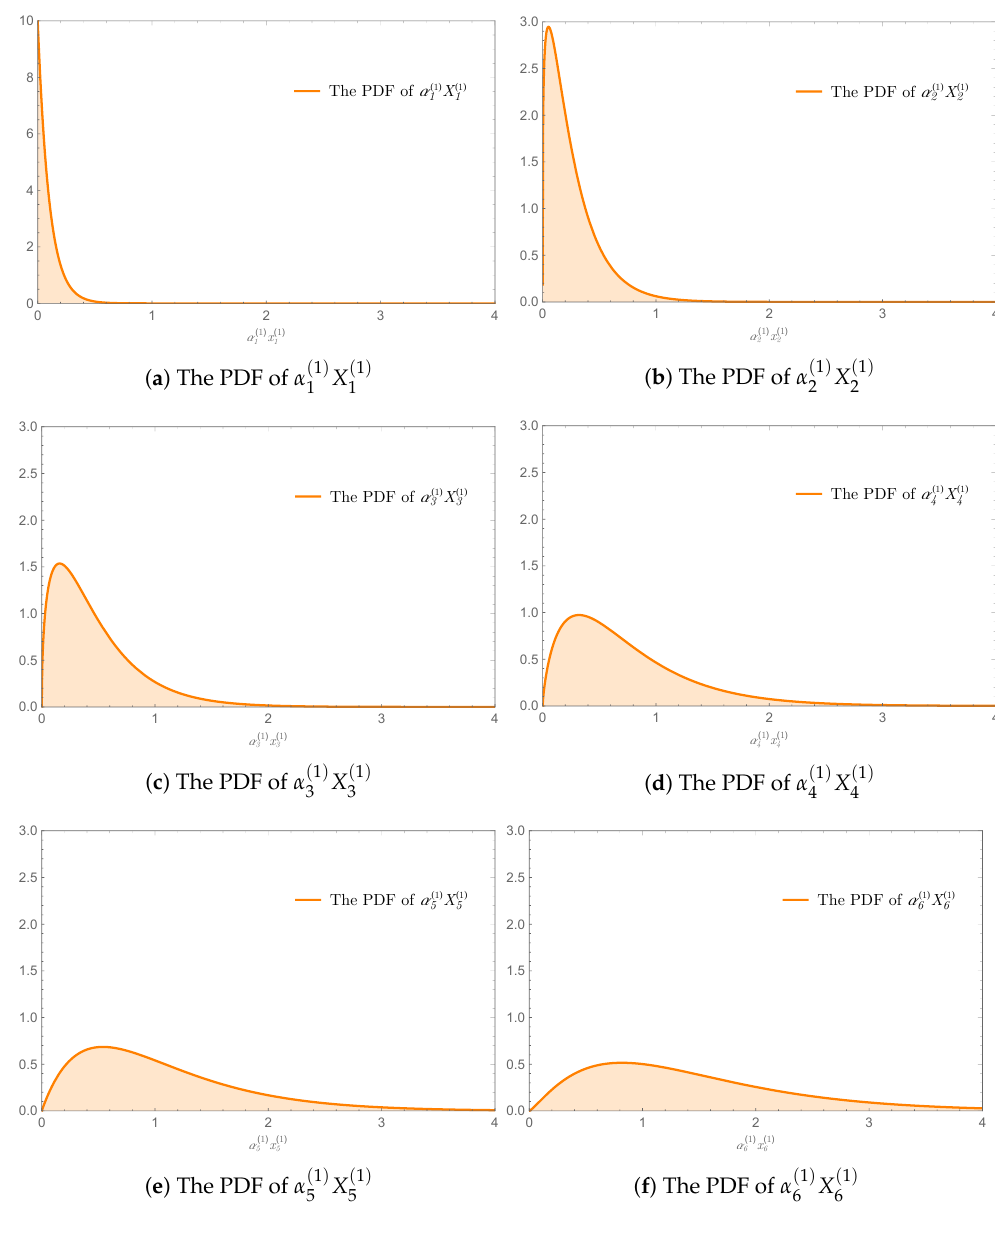
( 1 ) ( 1 ) X in which X i i ( 1 ) are displayed in Figure 1a. i